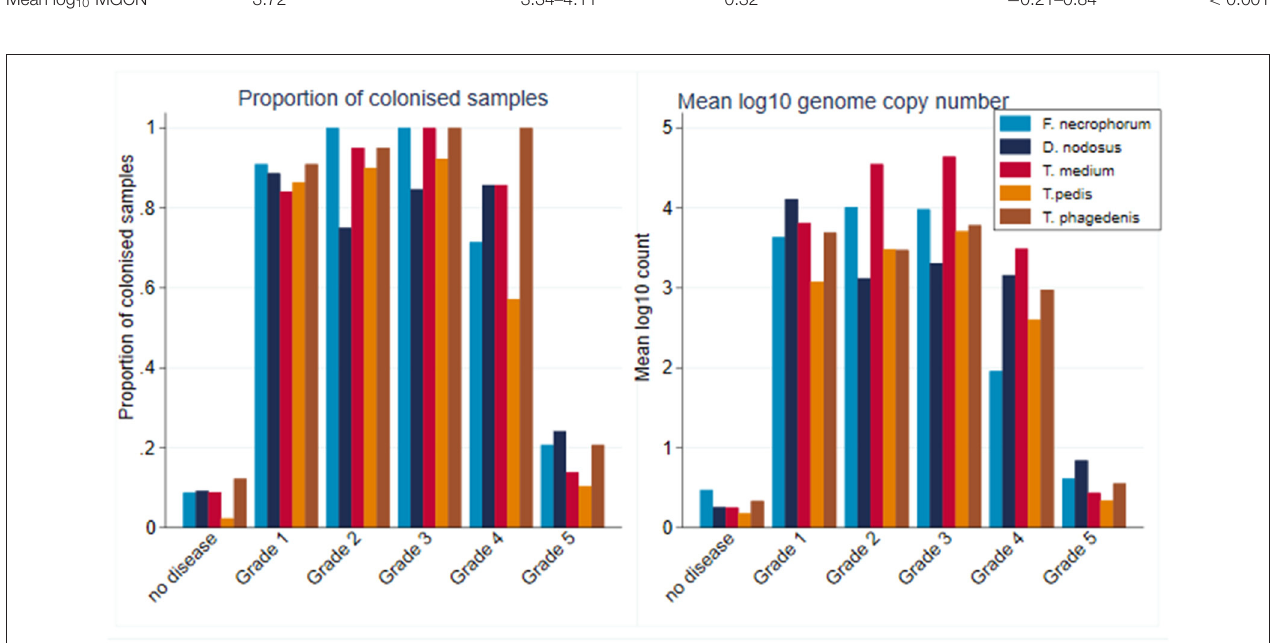
FIGURE 10 | Proportion of colonized samples and mean log 10 MGCN by CODD grade ( n = 15 sheep, n = 26